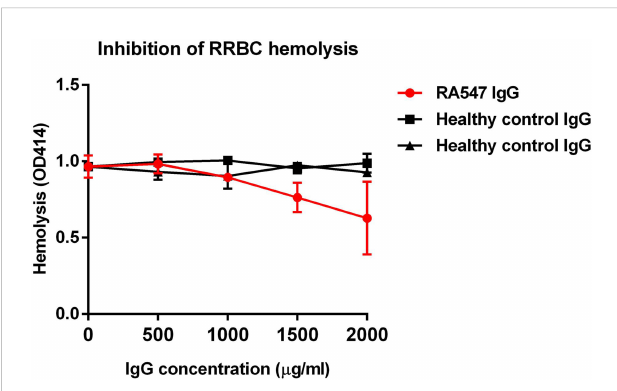
FIGURE 5 RA547 patient ’ s IgG dose-dependently inhibited RRBC hemolysis. Complement active normal human serum was mixed with RRBCs and IgG from patient or healthy controls, then incubated for 30 min at 37°C. Samples were centrifuged, and the OD of the supernatant was measured at 414 nm. Data are mean ± SD from two independent